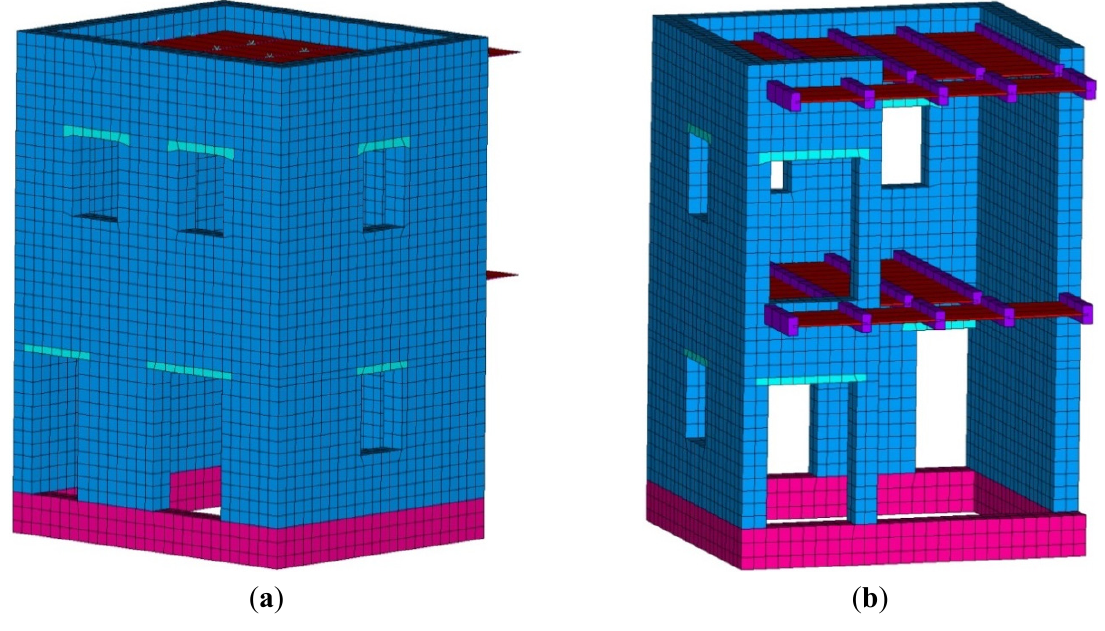
Figure 8. Finite element (FE) model of the URM prototype: ( a ) external and ( b ) internal views.